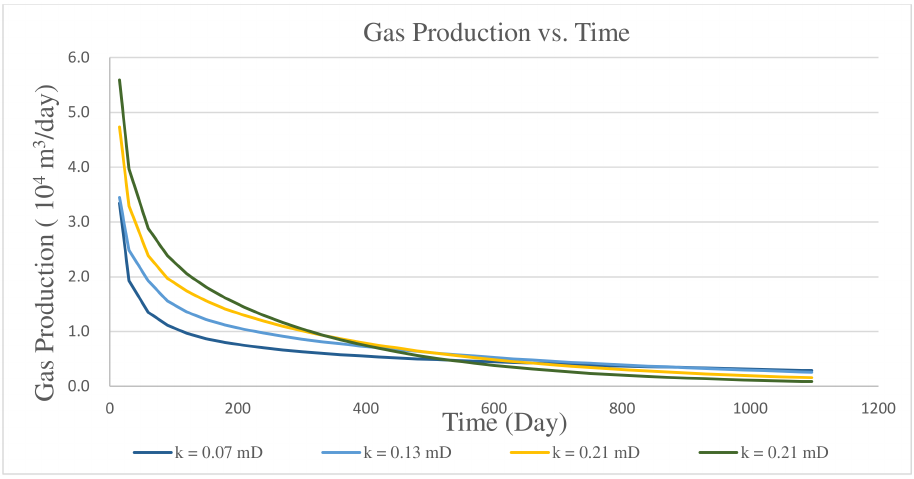
Figure 6. Simulated gas production at different permeabilities.